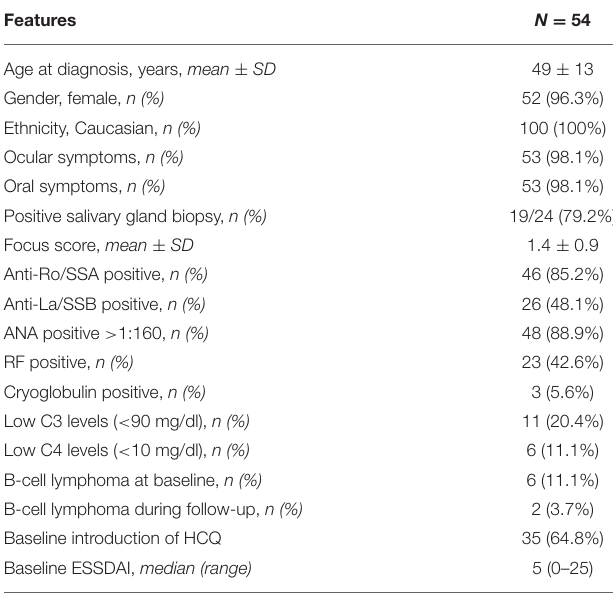
TABLE 3 | Characteristics of the patients taking hydroxichloroquine at the last follow-up visit.